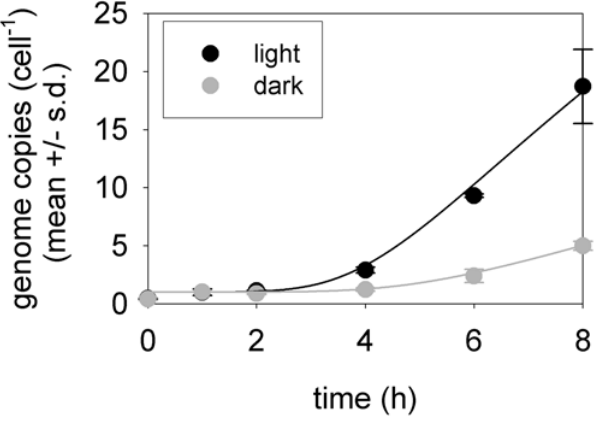
(c) Degradation of the host genome. Experimental